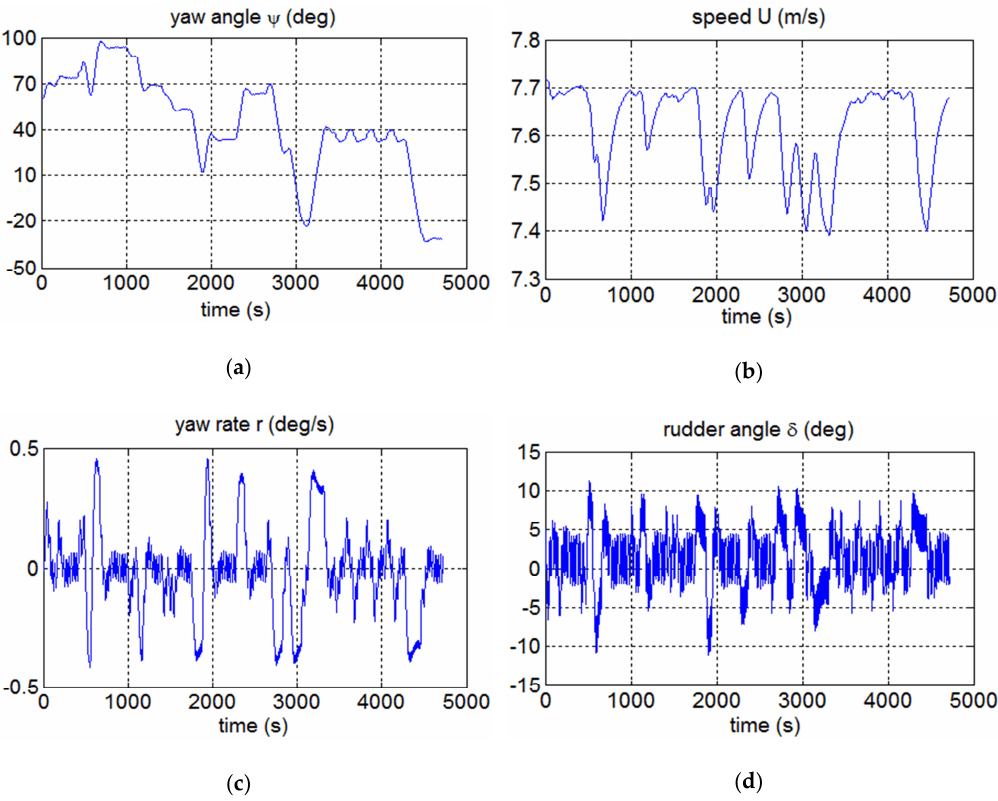
Figure 18. Real-time maneuvering data obtained by a PD controller. ( a ) Own ship yaw angle, i.e., the heading at every second. This data curve is consistent with the heading data of the algorithm at each step. ( b ) This diagram reflects the change of the own ship speed (m/s) during the path planning. There is a small decrease in the velocity at each turn, which is consistent with the actual situation. ( c ) This diagram shows that the yaw rate is limited to ±0.5°/s. ( d ) The rudder angle of each turn does not exceed the starboard or port rudder of 15°.